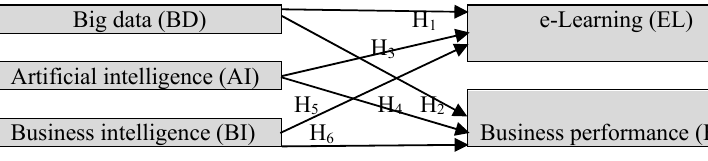
Fig. 1. The proposed study